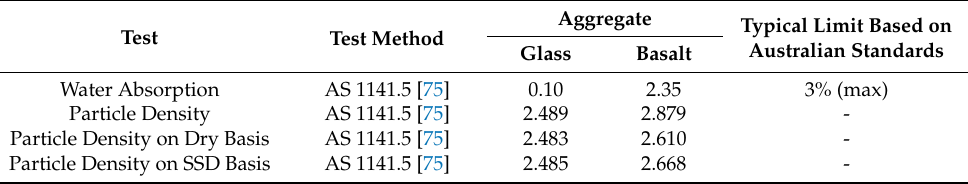
Table 6. Test results for evaluation of fine aggregate properties.